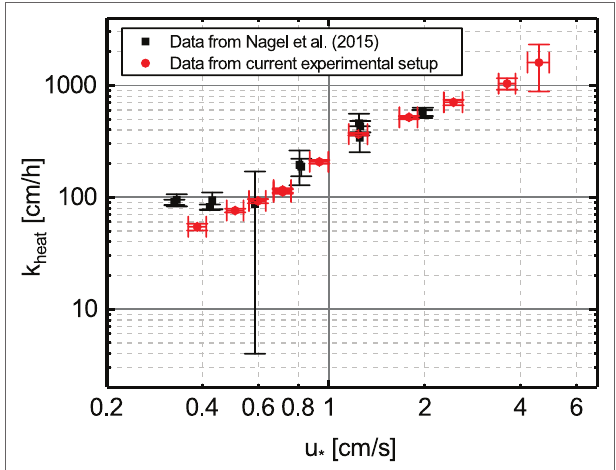
FigURe 16 | Comparison of data taken with the present experimental setup using a diffractive beam homogenizer and the amplitude damping method and data taken by Nagel et al. (2015) with a setup based on a cylindrical lens and a moving mirror for beam shaping and the amplitude damping method.